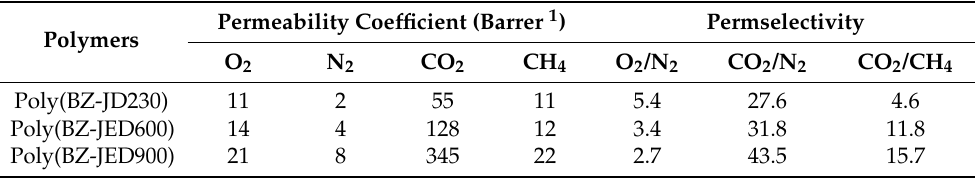
Table 3. Gas separation performance of PEG-based Table 3 . Gas separation performance of PEG-based polybenzoxazine.